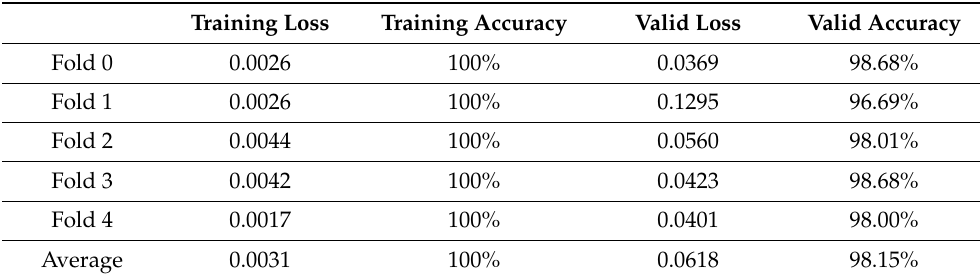
Table 2. Quantitative results of the proposed model on dataset A. Fold 0, fold 1, fold 2, fold 3, and fold 4 are the respective results in the fivefold cross-validation